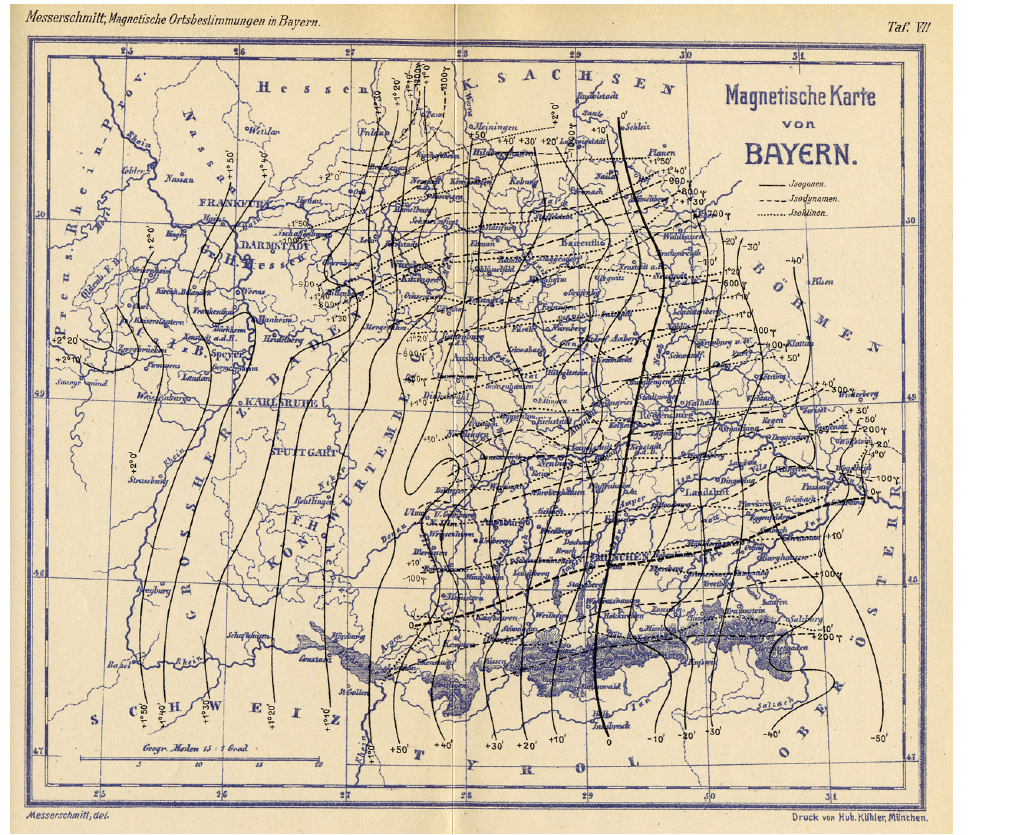
Figure 11. Geomagnetic map for Bavaria including the territories in the Palatinate to the west of the river Rhine. The measurements were made by Messerschmitt between 1903 and 1906 using a nonmagnetic TESDORPF theodolite. The data have been reduced to the mean values in Munich in 1905 (Messerschmitt, 1906). Reference data for Munich in 1905 are D = − 10 ◦ 07 . 3 (cid:48) E; I = 63 ◦ 10 . 5 (cid:48) ; and H = 20635nT. The map shows isolines of D (full lines), H (dashed lines) and I (dotted lines). Differences between the isolines are 10 (cid:48) for D and I , 100nT for H .